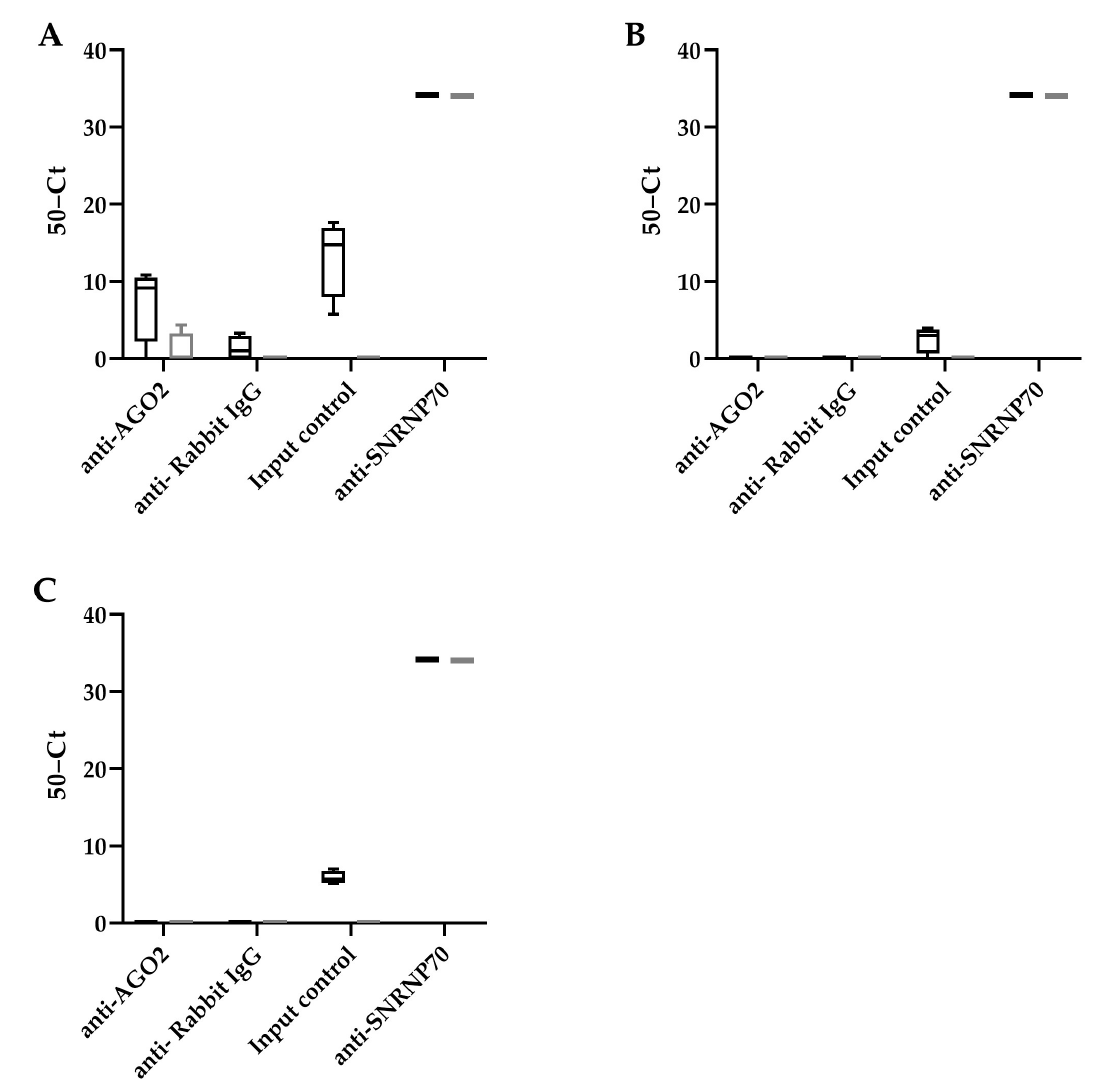
Figure 2. HBV-miR-6 interacts with RICS. RNA immunoprecipitation using either an AGO2, NRNP70 (positive control), or IgG control antibodies was performed in HepG2.2.15 cells (black bars) and HepG2 cells (grey bars). The binding of HBV-miR-6 ( A ), HBV-miR-7 ( B ), and HBV-miR-8 ( C ) to AGO2, and U1 snRNA to SNRNP70, were measured using RT-qPCR. The graphs represent averages of results from two independent